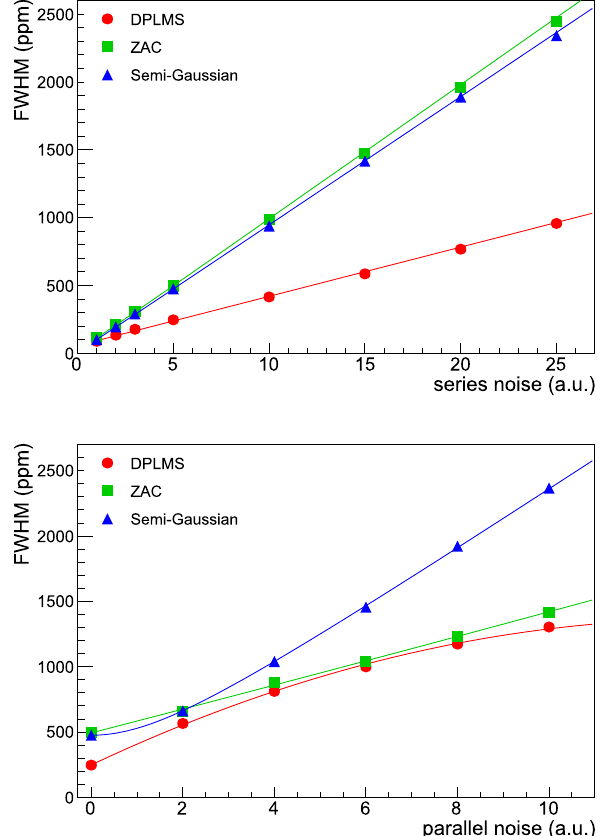
Fig. 12 The energy estimation results (in terms of peak relative FWHM) obtained with the three filtering techniques: the DPLMS fil- ters (red circles), the ZAC filters (green squares), and the semi-gaussian shaping filters (blue triangles) for an increasing amount of series noise (top panel) and of parallel noise (bottom panel)